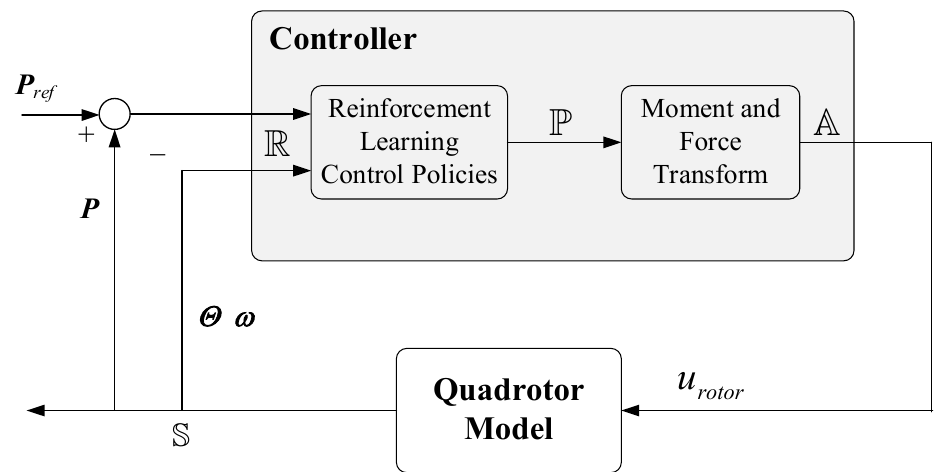
Figure 2. Quadrotor closed-loop control system.